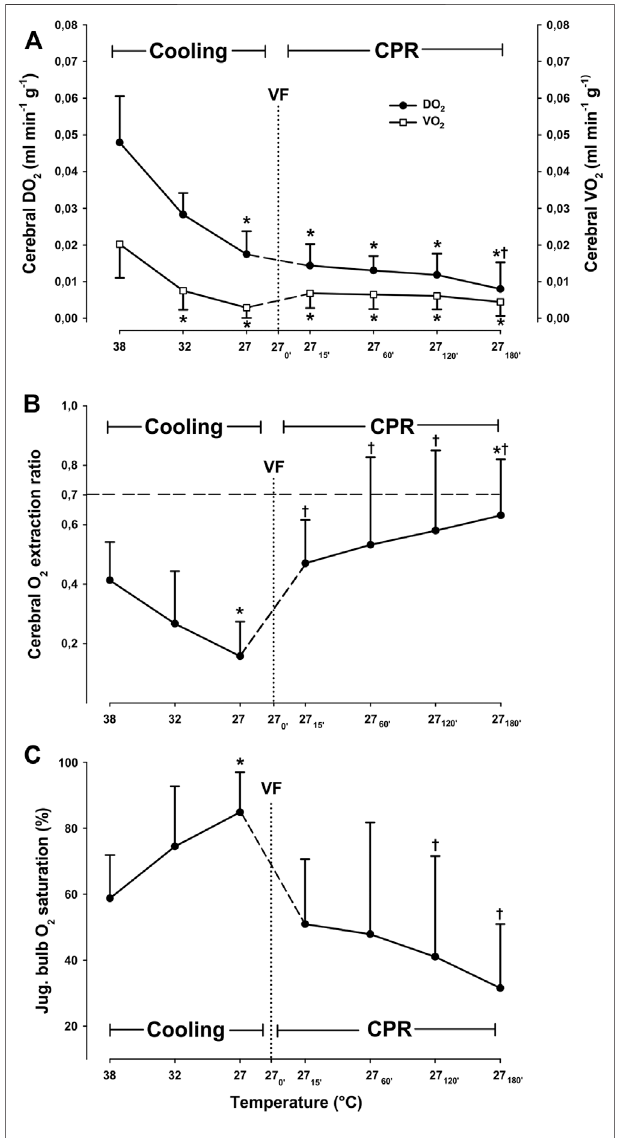
FIGURE 2 | Cerebral oxygen transport, (A) cerebral O 2 extraction ratio (B) ,andjugularbulbO 2 saturation (C) duringcoolingand3 hCPRat27 ° C( n = 8). Values are mean ± SD ( n = 8). * p < 0.05 vs. intragroup 38 ° C baseline; † p < 0.05 vs. intragroup spontaneous circulation at 27 ° C.